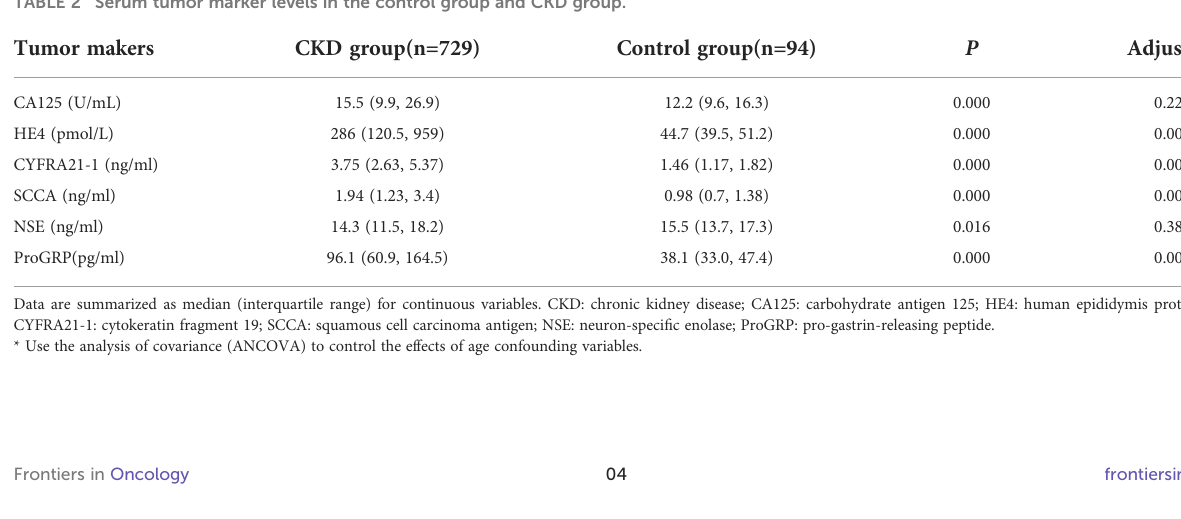
TABLE 2 Serum tumor marker levels in the control group and CKD